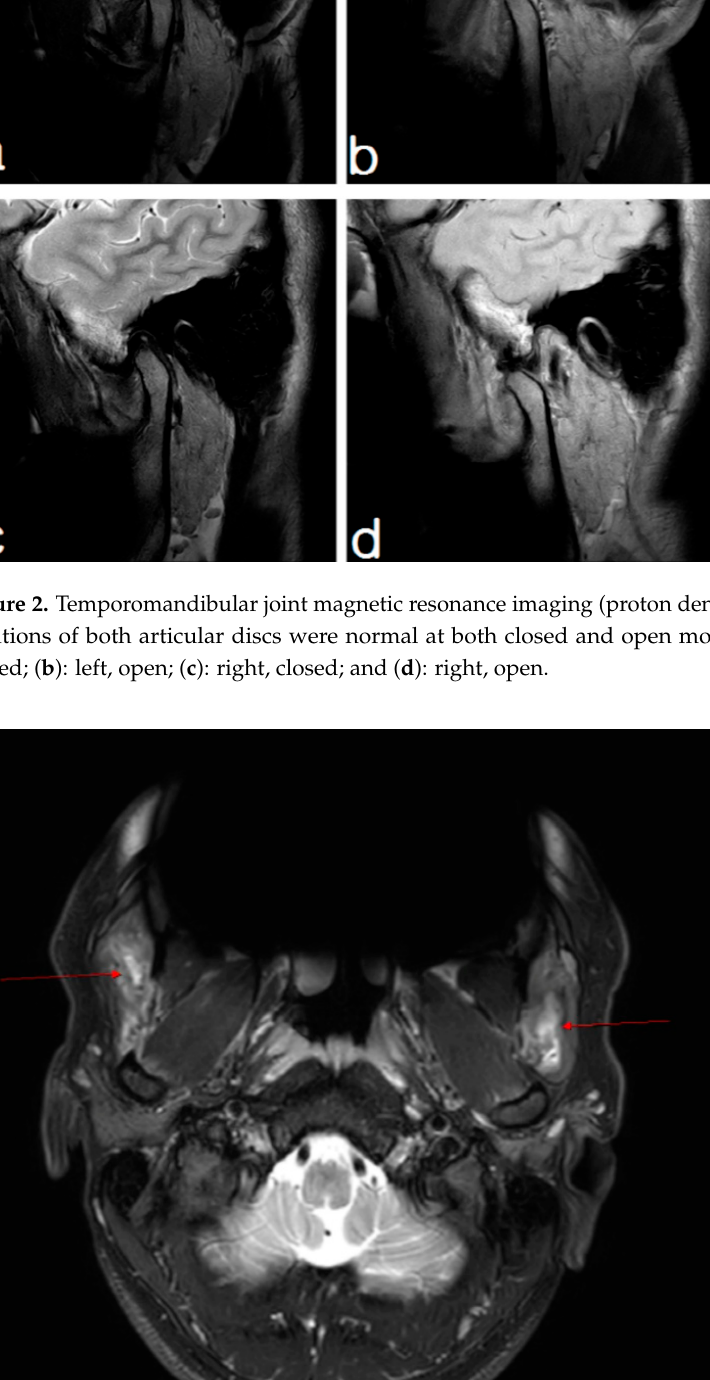
Figure 3. Temporomandibular joint magnetic resonance imaging (axial view). Heterogeneous hyperintense T2 signals were observed within the masseter muscle of both sides (arrows). 2.1.3. Treatment At the first visit, antibiotics (Augmentin 625 mg 3 times a day for 10 days) and anal ‐ gesics (Zaltoprofen 80 mg 3 times a day for 10 days) were prescribed based on the possi ‐ bility of infection following the invasive treatment. After 1 week, the amount of mouth